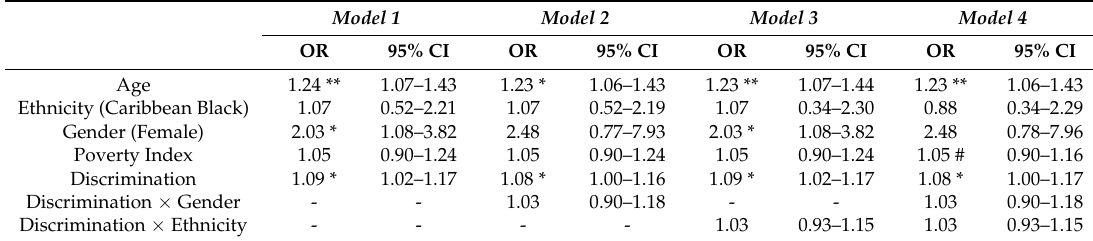
Table 2. Summary of logistic regressions for the associations between discrimination and suicidal ideation in the sample